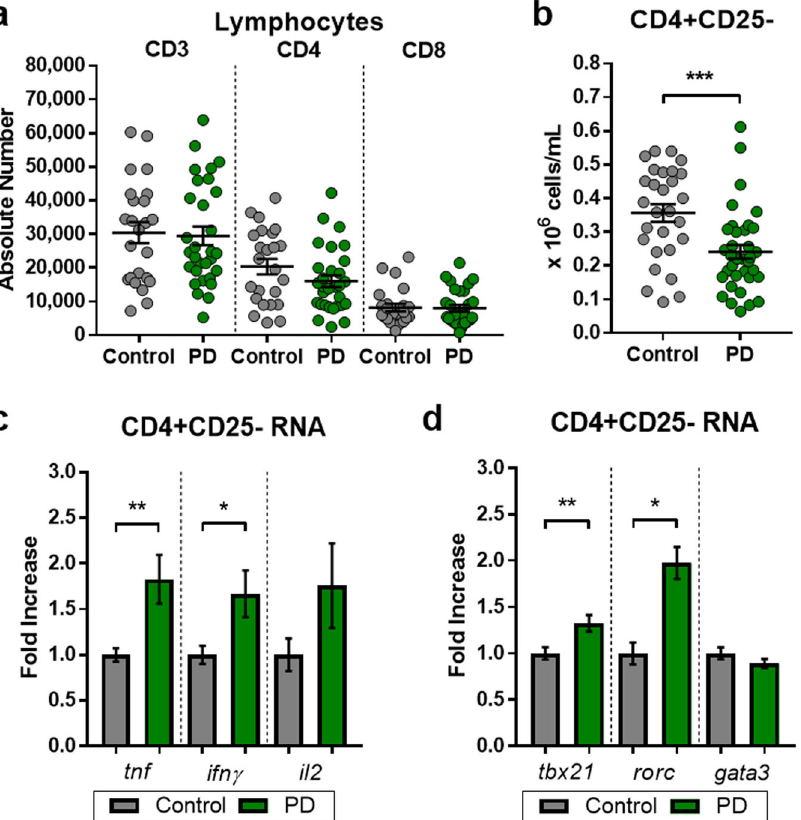
Fig. 2 Peripheral T-cell changes in PD. An investigation into the complementary T-cell compartment of PD patients and controls to fi nd pro- in fl ammatory changes was done. a Analysis of lymphocyte populations in blood samples from control and PD patients show no discernable difference in the numbers of CD3, CD4, or CD8 cell populations following fl ow cytometry (C n = 24, PD n = 30). b After bead/column-based isolation methods from peripheral blood, the number of T effector cells (CD4 + CD25-) is decreased in PD patients compared with controls (C n = 28, PD n = 35). Functional analysis of T effector polarization was done following isolation using RNA transcript analysis of c pro- in fl ammatory cytokine transcripts, tnf, ifn γ , and il2 , and d RNA of transcription factors for T-cell polarization, tbx21, rorc , and gata3 (C n = 16, PD n = 17). Numbers shown as averages ± SEM with Student ’ s t test or one-way ANOVA with appropriate post hoc testing for multiple comparisons as appropriate. P -values are * p < 0.05, ** p < 0.01, and *** p <